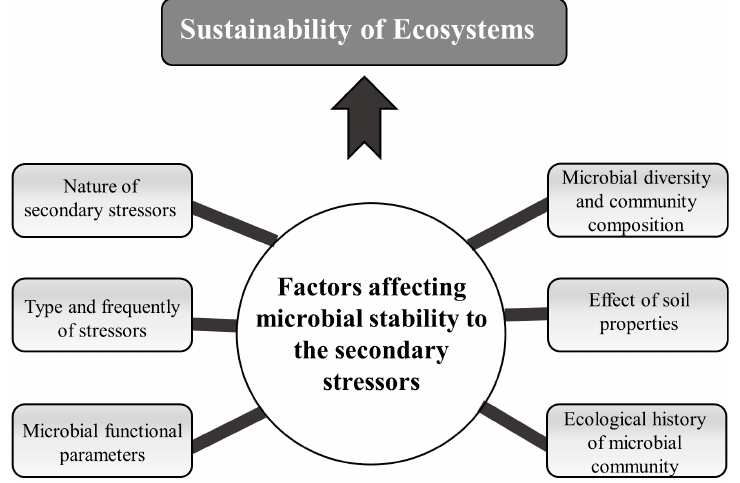
Figure 2. Schematic representation of possible factors affecting the stability of soil microbial communities in historically metal-contaminated fields in the face of secondary stressors.